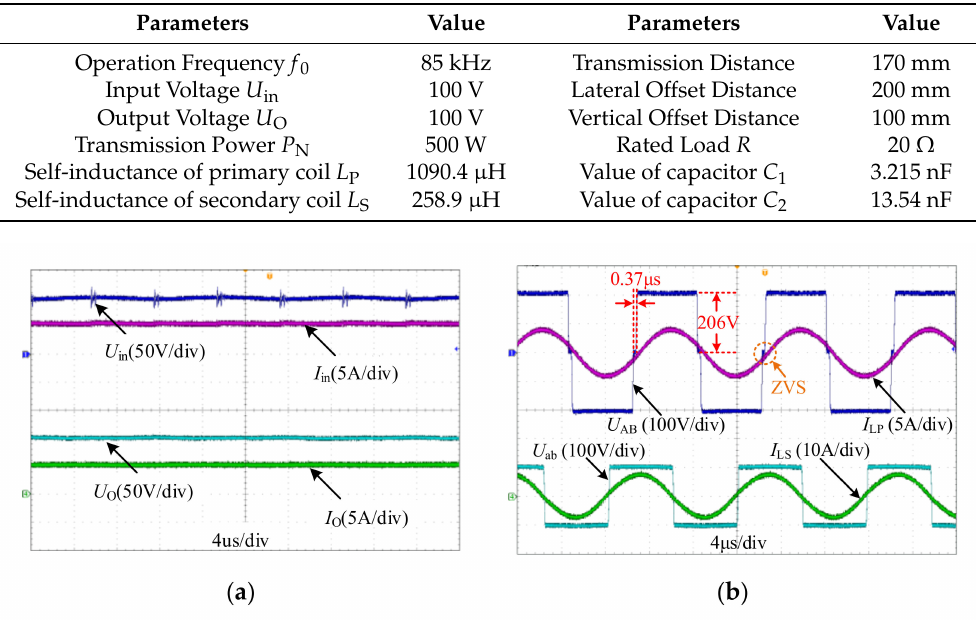
Figure 11. The voltage and current waveforms at each node of the system in an aligned case. ( a ) DC/DC node; ( b ) AC/AC node.